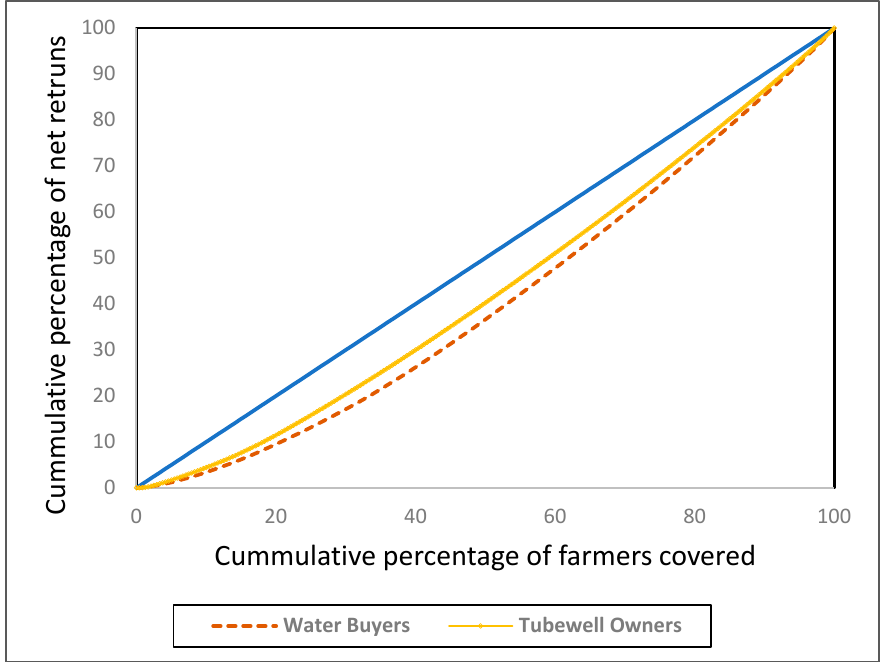
Figure 2. Distribution of net returns to cultivation across water markets.